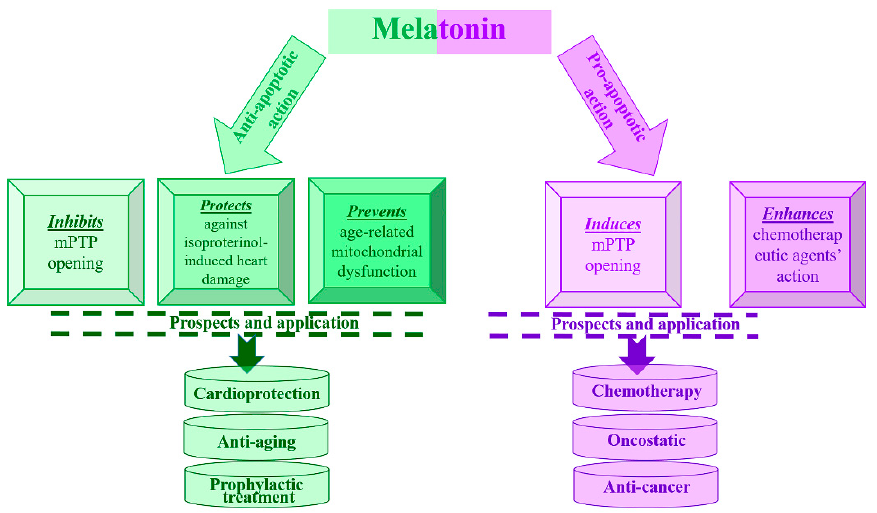
Figure 1. Scheme of the discovered opposite effects of melatonin and potential areas of its applica- tion.